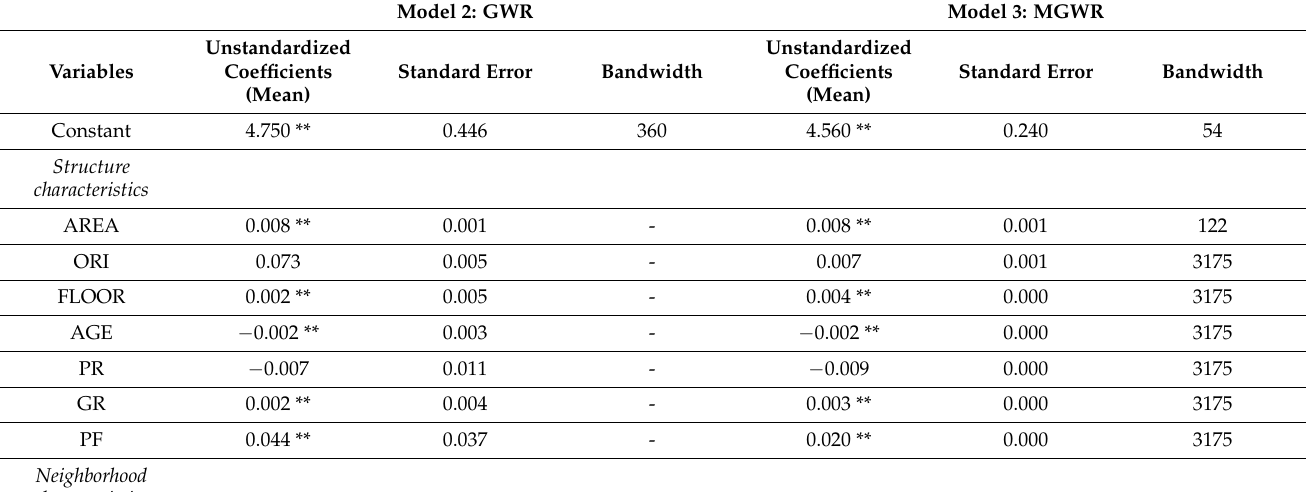
Table 3. Performance of GWR and MGWR ( n = 3175). Model 2: